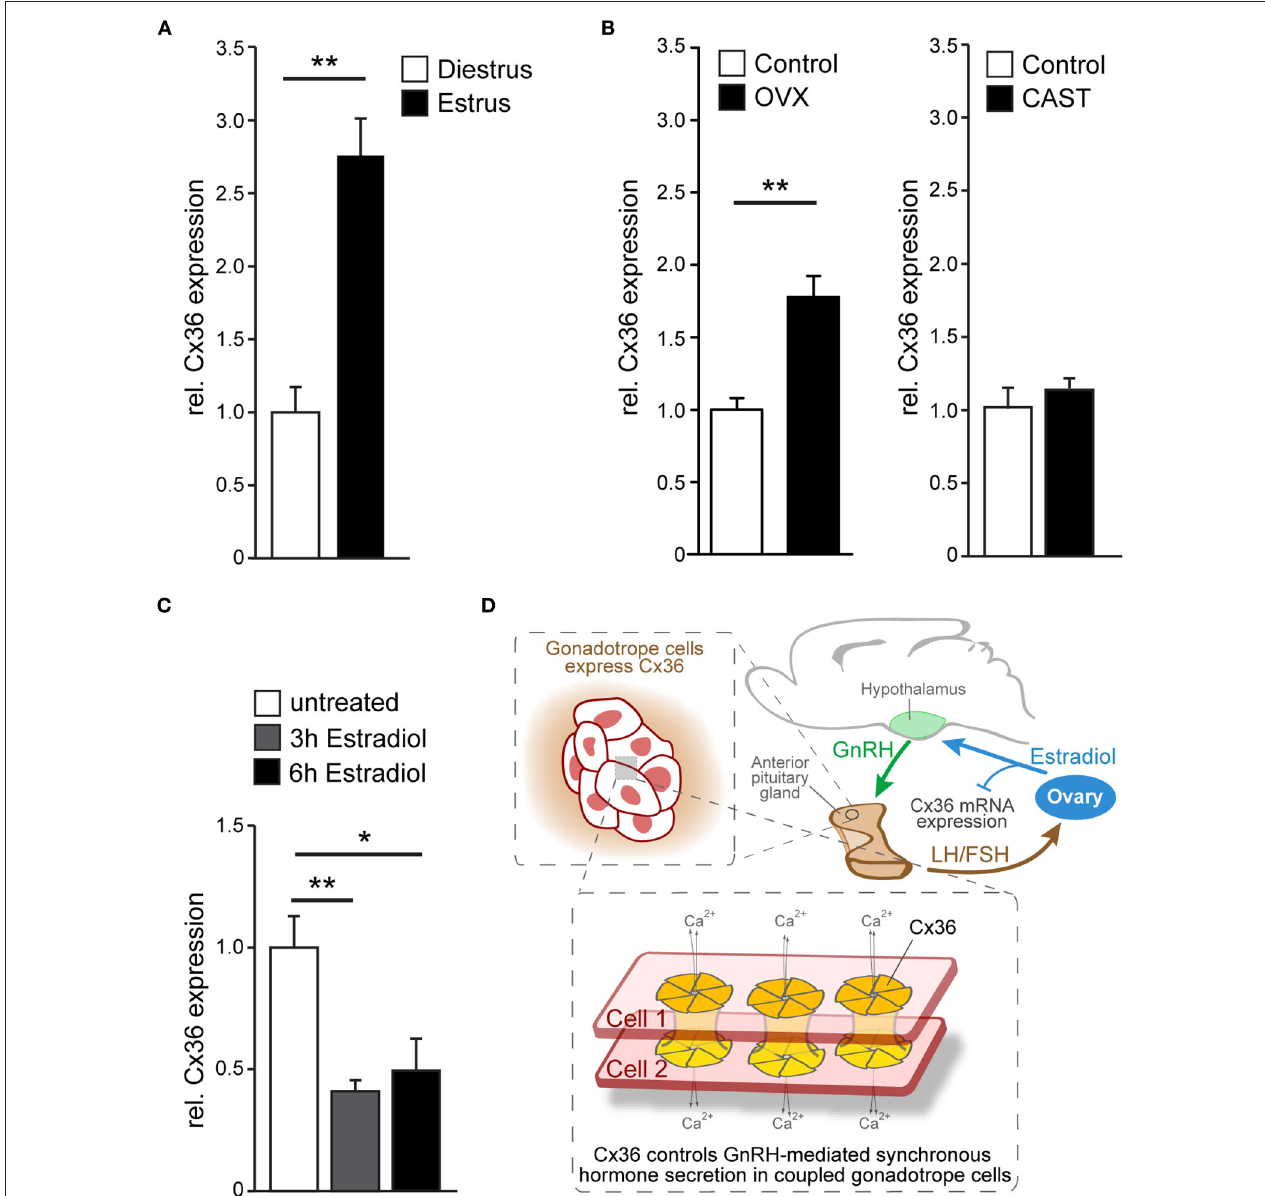
FIGURE 4 | Cx36 expression is regulated in a sex-specific manner. (A) Cx36 mRNA expression in the pituitary gland of female wt mice is augmented in estrus ( n = 9) compared to diestrus ( n = 5) as shown by qPCR analysis. Mean ± SEM; ** P ≤ 0.01; Student’s t -test. (B) Ovariectomy results in increased Cx36 mRNA expression ( n = 6, control n = 9) while castration ( n = 4, control n = 3) has no effect on Cx36 mRNA expression in the pituitary gland of males. Mean ± SEM; ** P ≤ 0.01; Student’s t -test. (C) Treatment of cultured pituitary cells from wt females with estradiol leads to a rapid suppression of mRNA expression. n = 4 independent experiments, performed in triplicate or quadruplicate. Mean ± SEM; ** P ≤ 0.01; * P ≤ 0.05; ANOVA, Bonferroni post-hoc test. (D) Schematic diagram illustrating Cx36 action on the hypothalamic-pituitary-ovarian axis. Cx36 controls GnRH-mediated synchronous hormone secretion (LH/FSH) in coupled gonadotrope cells in the pituitary gland. LH and/or FSH stimulate estradiol production in the ovaries, which in turn represses Cx36 mRNA expression in the pituitary gland.